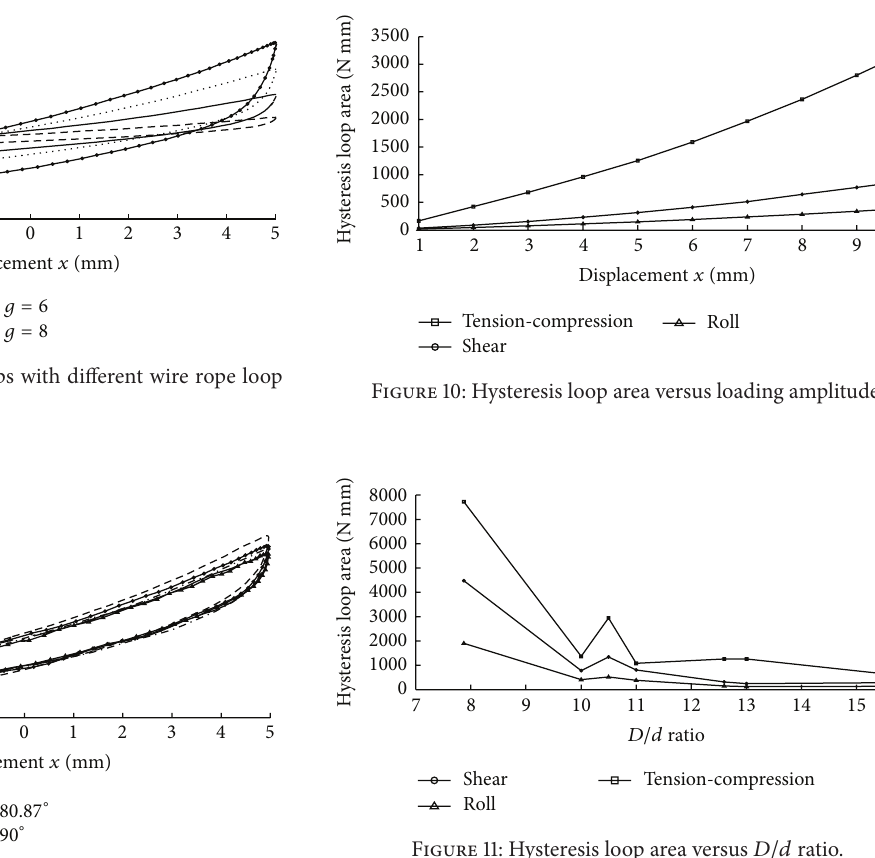
Figure 11: Hysteresis loop area versus 𝐷/𝑑 ratio.